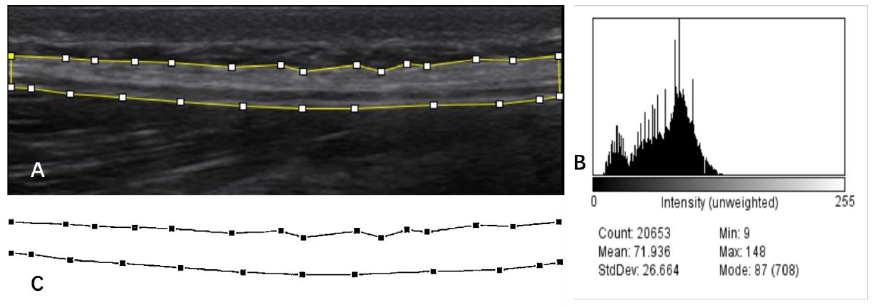
Figure 3. Thoracolumbar fascia thickness and echo intensity measurement process. ( A ). Use ImageJ to draw the boundaries of the TLF. ( B ). CSA of TLF histogram displayed. ( C ). Hyperbolic diagram of the TLF of CSA obtained after texture extraction by AI imaging software (version 1, Yongzhou, China).